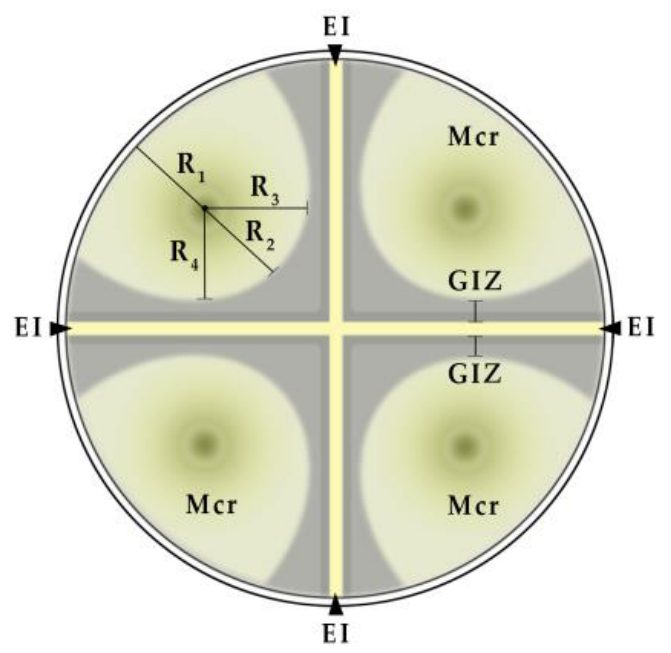
Figure 7. Scheme for evaluating the antifungal activity of endophytic bacteria based on indicators of linear growth of micromycete colonies: EI — endophytic isolate; GIZ — growth inhibition zone; Mcr — micromycete; R – R — micromycete colony radii . 1 4